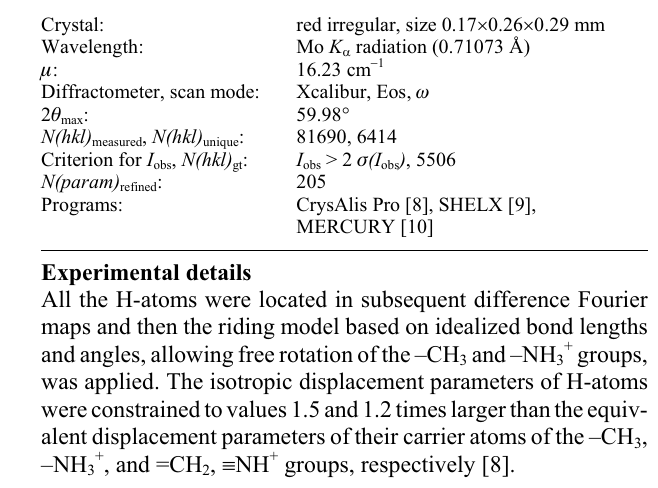
Table 1. Data collection and